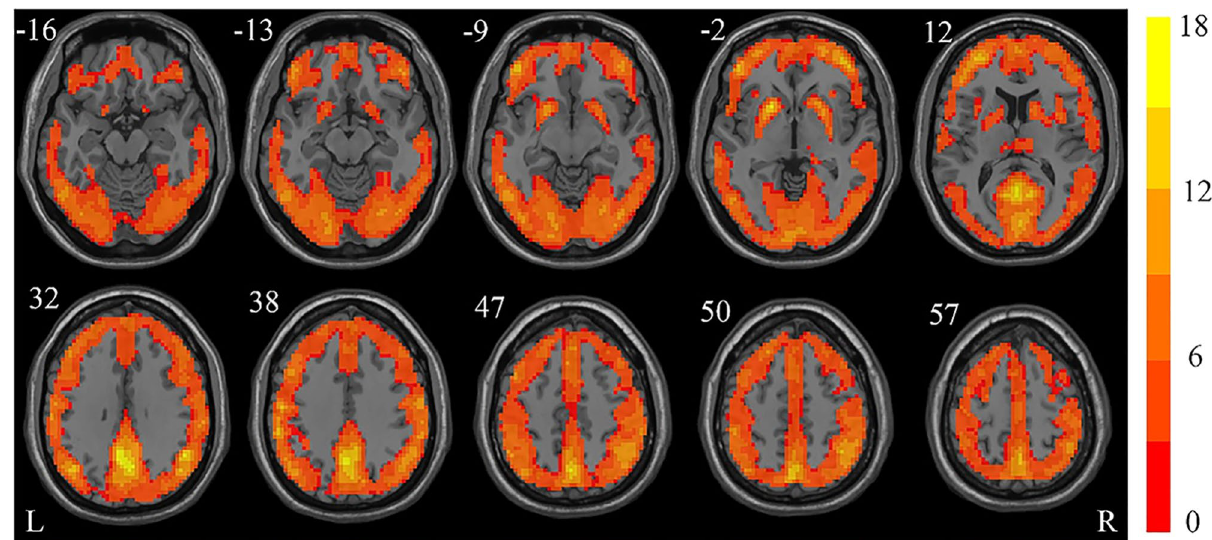
Figure 2. The one-sample t -test results of the growth hormone deficiency group shown as a KCC map (FDR corrected, p < 0.05). The figure was presented using the free DPABI software. Red areas indicate a positive ReHo. The number above each image refer to the z-plane coordinates of the Montreal Neurological Institute space. ReHo regional homogeneity, L left, R right.